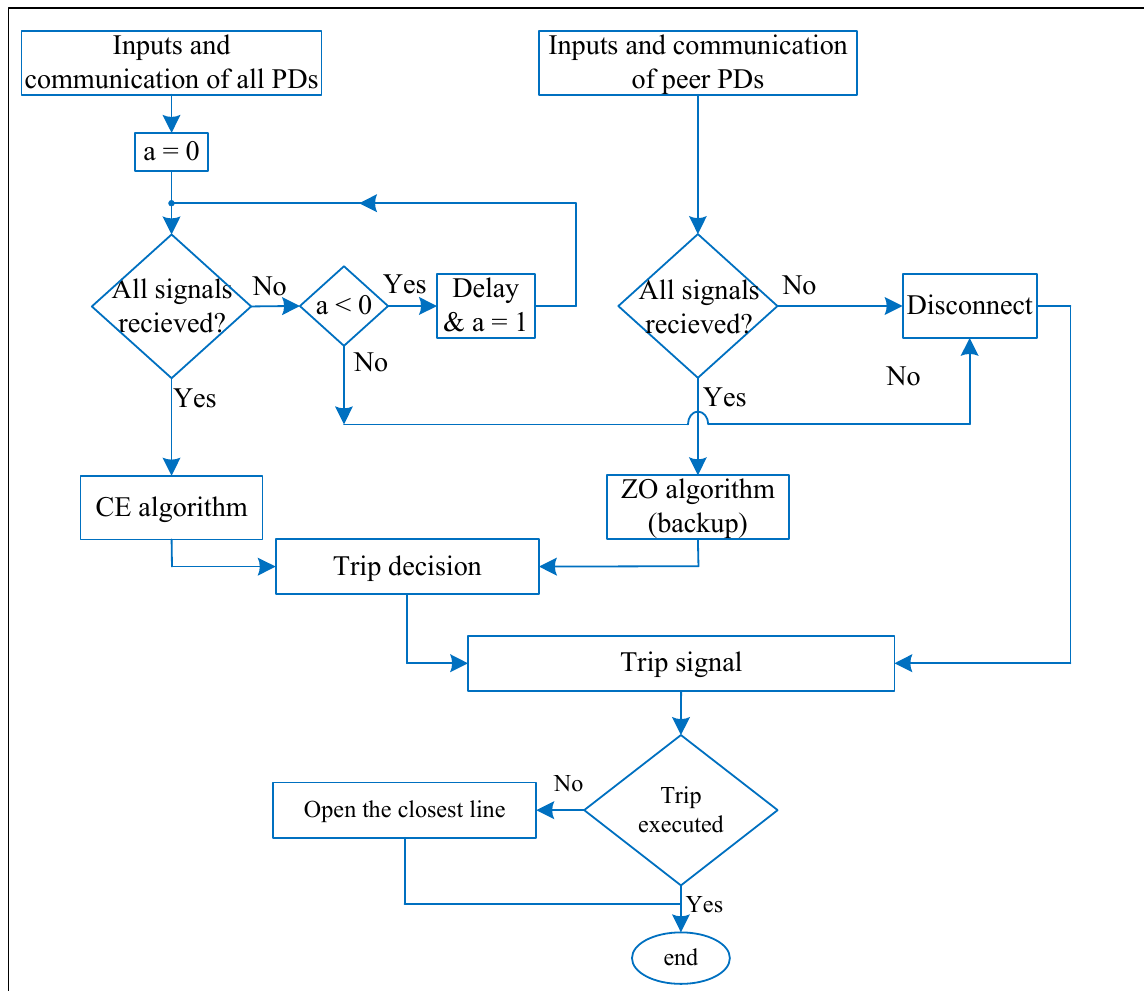
Figure 4. Flowchart of the proposed protection scheme.